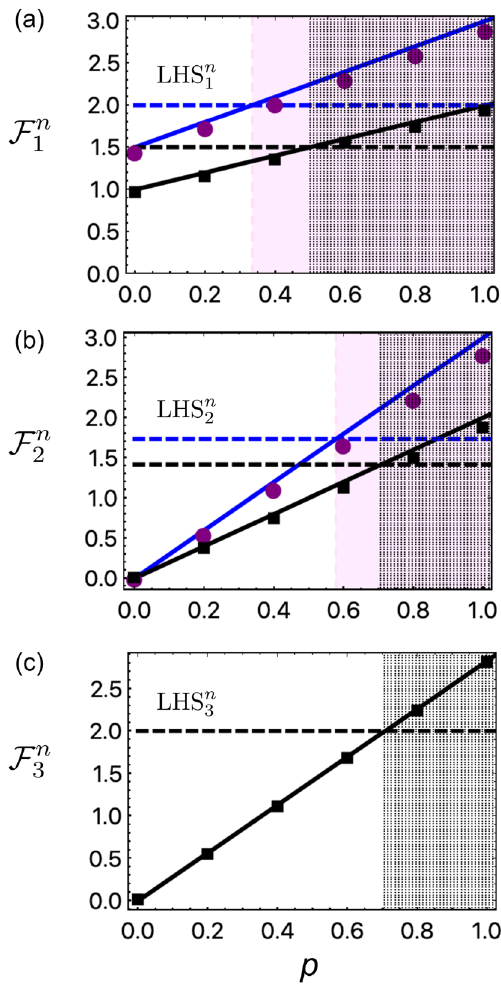
Figure 3. Theoretical and experimental characterizations of ( a ) entanglement, ( b ) steerability, and ( c ) Bell 1, 2, 3 and n 2, 3 , refers to different LHS models in nonlocality for the bipartite Werner state. The LHS n i , i = = the three scenarios, see the derived local uncertainty relations of (3–5). All experiments were implemented on an integrated silicon-photonics quantum device. Points denote experimental data and lines denote theoretical 3 and n 2 measurement settings; blue and black lines are prediction: circular and square points are for n = = 3 and n 2 measurement, respectively. Red shaded (black dotted) regime in ( a – c ) identifies the p for n = = mixing parameter of the Werner state ρ W , above which the state is certified as entanglement, steerable, and 3 ( n 2 ) measurement settings, respectively. Horizontal dashed lines are plotted for the Bell nonlocal, for n = = σ ) estimated from 20 sets of guidance the achievable upper bound of the inequality value, F n k . Note error bars ( ± data are too small to be invisible in the